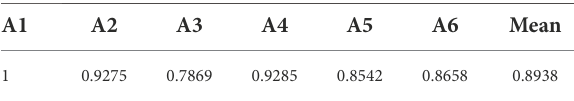
TABLE 5 Reliability of data analysis ability.